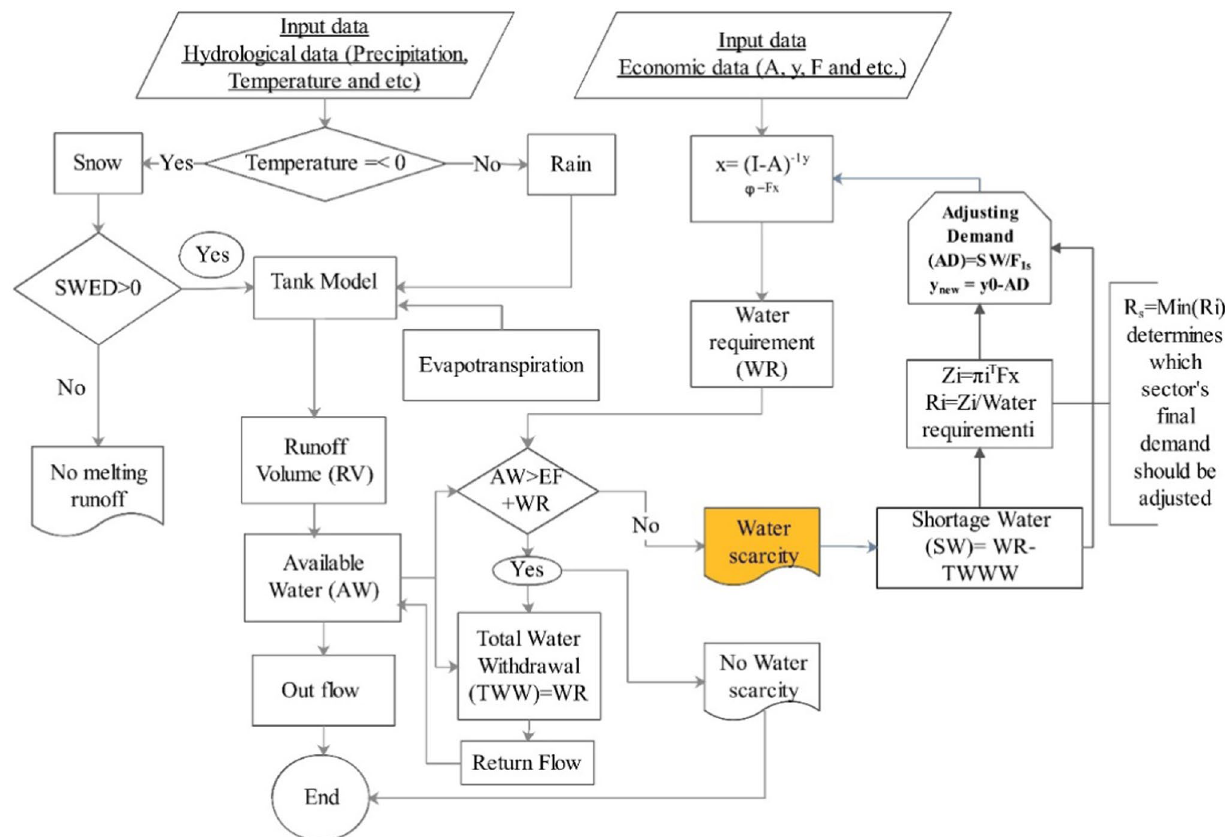
Fig. 5 The temporal coupled model